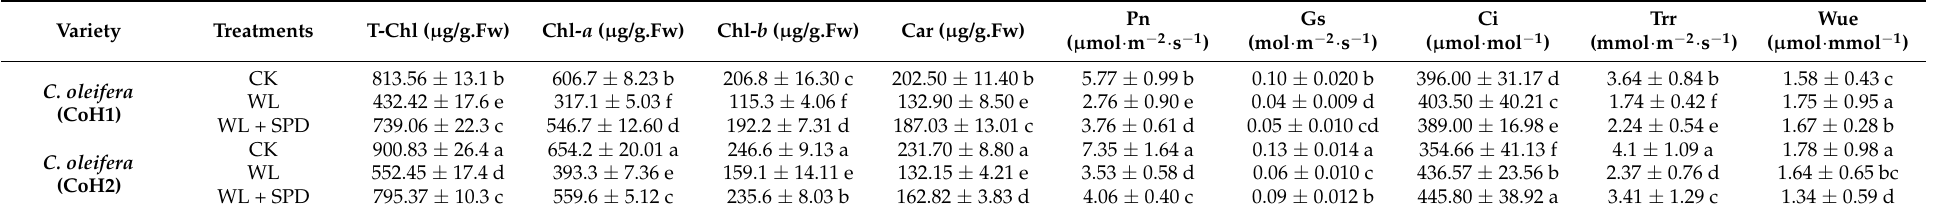
Table 3. Variations of the photosynthetic parameters in C . oleifera leaves under WL and exposed to SPD.